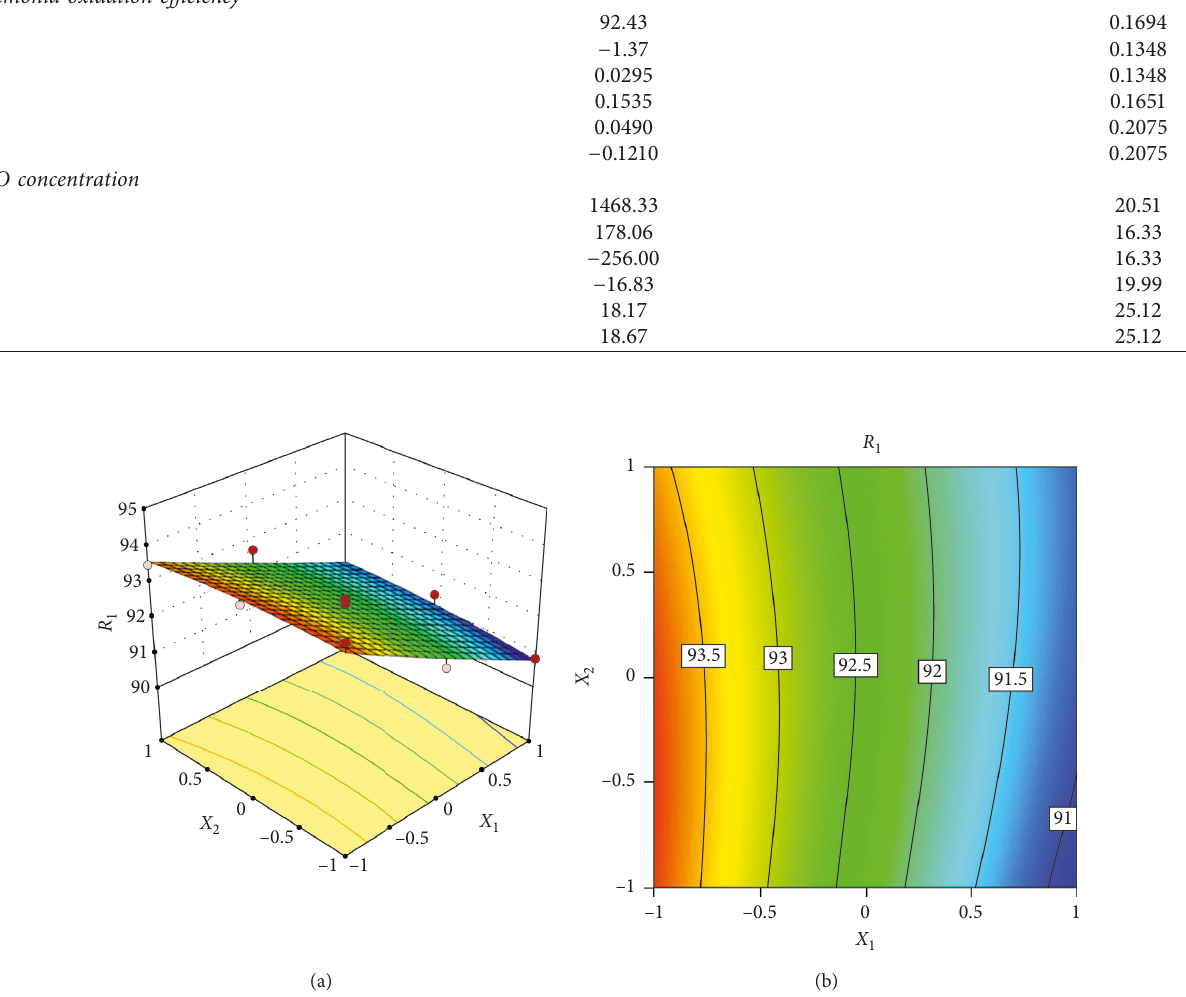
1 and X 2 on the response variable R 1